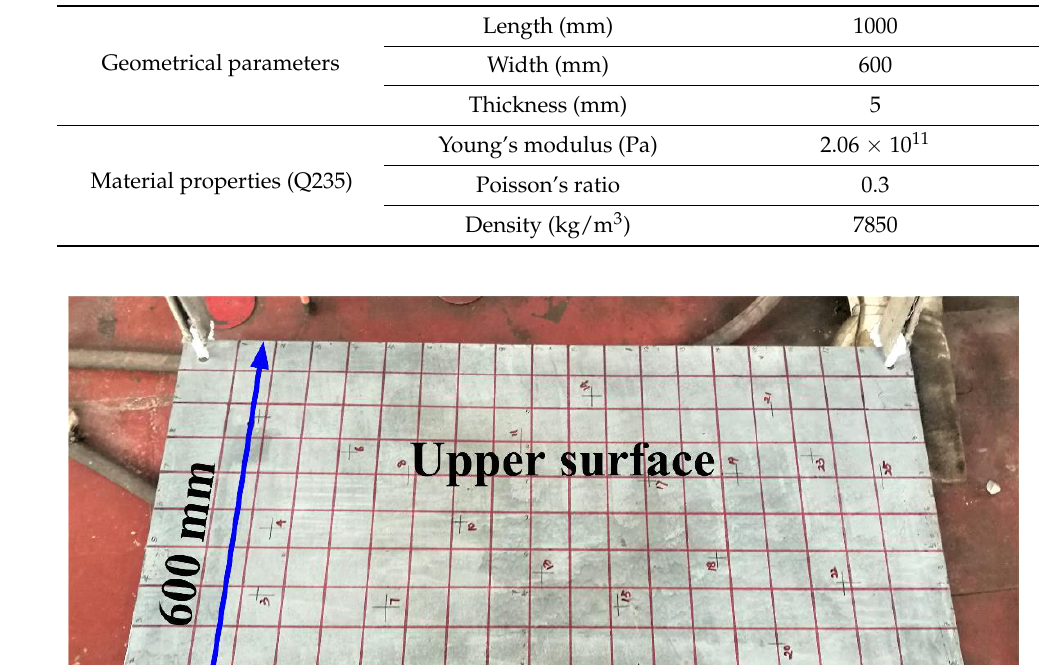
Table 1. Details of the experimental model.